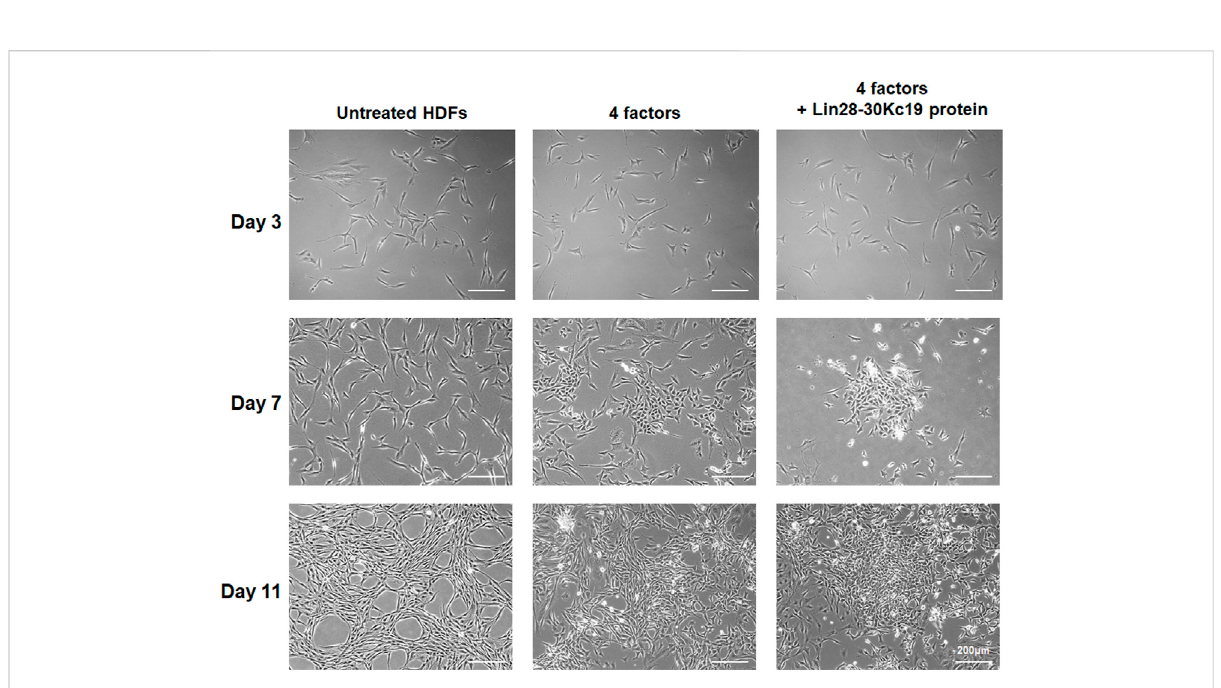
Morphological comparison of hiPSCs. Morphological changes of the fi broblasts were observed in untreated HDF (left), hiPSCs generated by four factors (middle), and hiPSCs produced by four factors with theLin28-30Kc19 protein (right), at days 3, 7, and 11, respectively. Scale bars indicate 200 μ